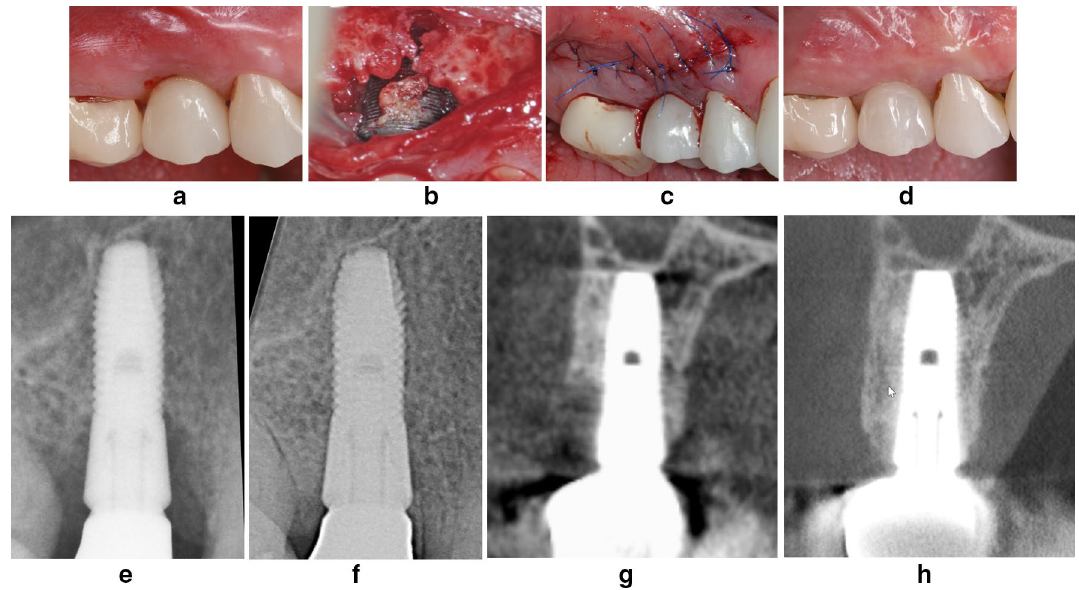
Fig. 2 a Severe peri‑implantitis lesion with suppuration and bleeding on probing. b Access to the severe buccal peri‑implant bony lesion by the LAPIDER approach. c Hard and soft tissue defect grafting and bilaminar wound closure. d At 3‑year follow‑up examination no signs of a peri‑implant infection are left. e The baseline radiograph reveals a severe interproximal bone loss. f A radiograph at 2‑year follow‑up examination shows the complete interproximal regeneration. g The pre‑operative CB‑CT shows a severe buccal bone loss. h At 3‑year follow‑up a CB‑CT reveals the